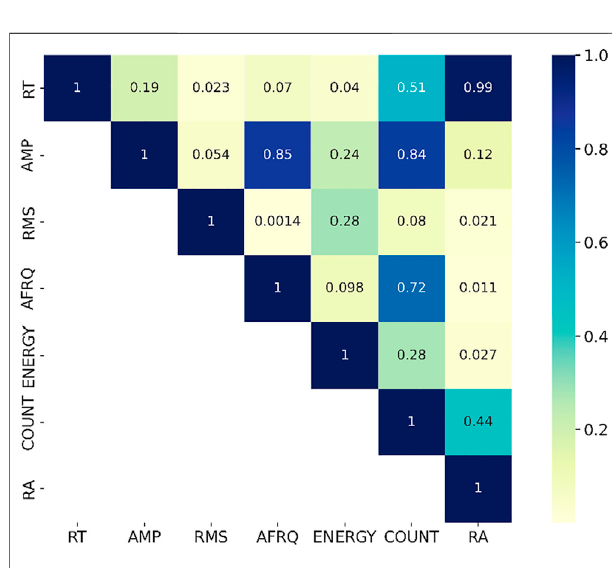
FIGURE 3 | Correlation coef fi cients among acoustic emission